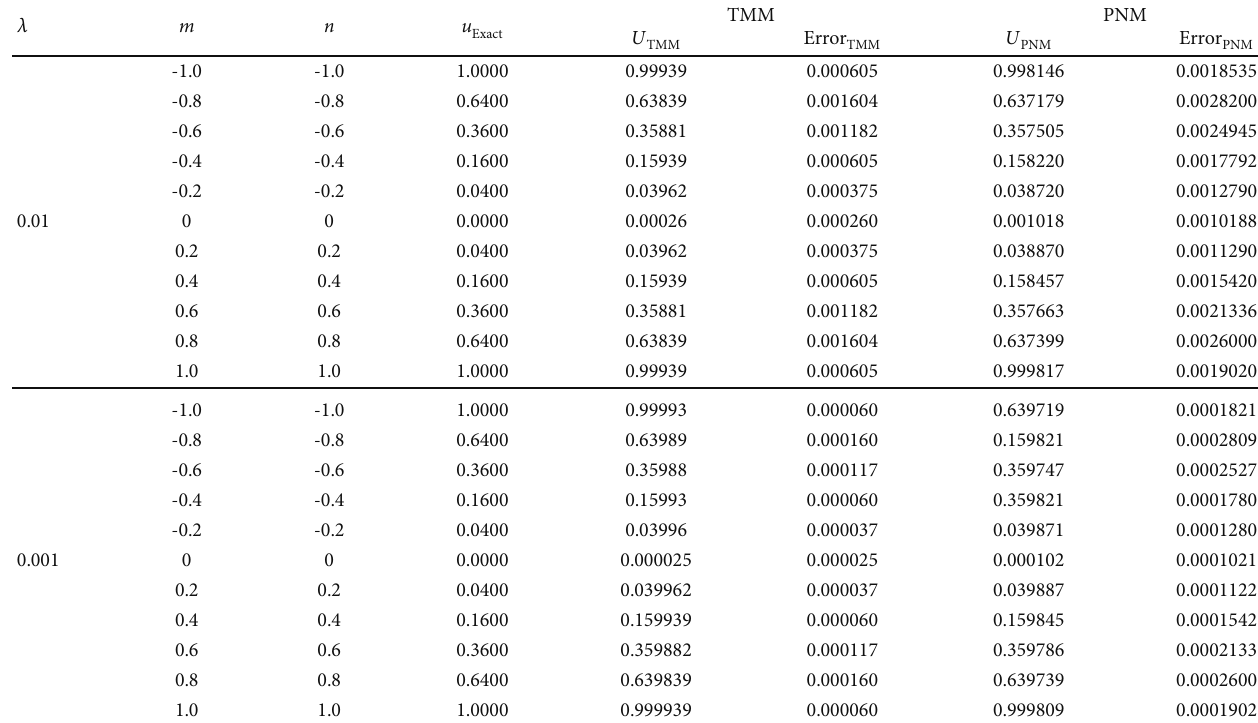
Table 2: Numerical values and absolute error values by using TMM and PNM, n = 20 , at nonlinear case k = 2 .